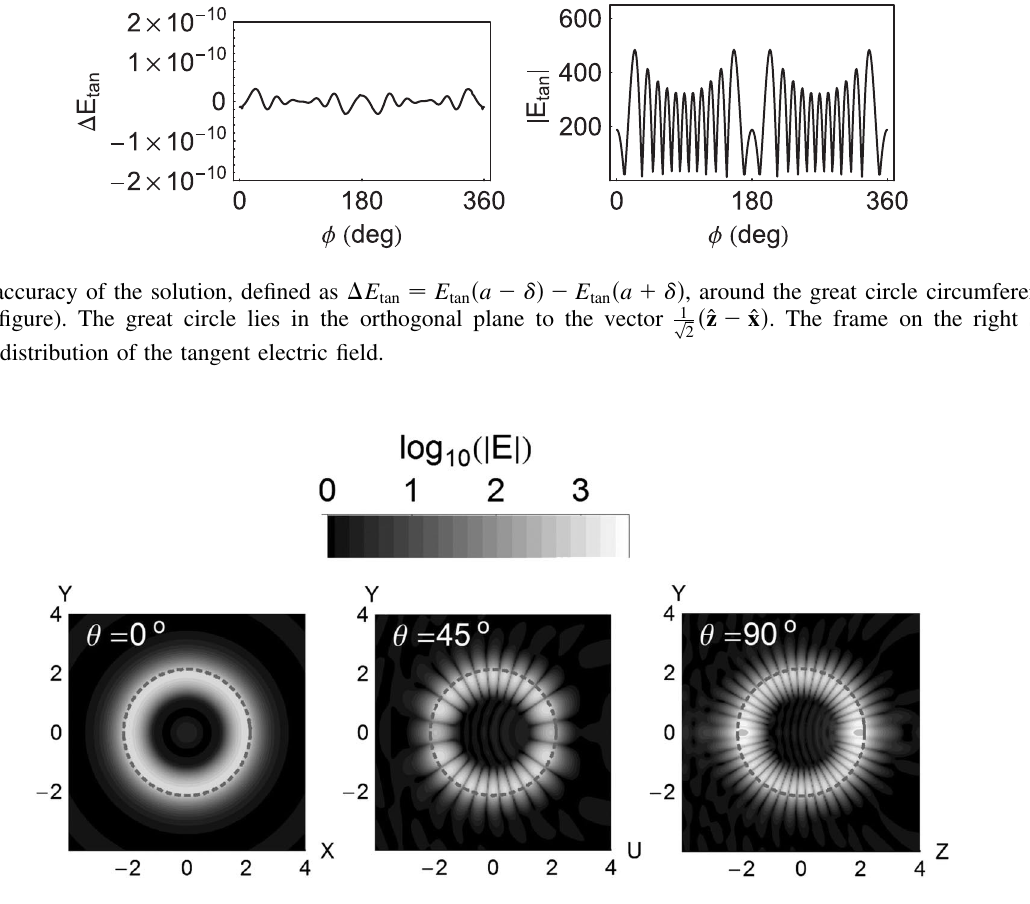
FIG. 4. Electric field distribution of WGM resonance for a perfect dielectric sphere. The sphere is characterized by (cid:1) (cid:2) 4 , radius a (cid:2) 2 : 134 697 , and is excited by a circularly polarized wave propagating along the z axis. The parts of the figure show distributions of the electric field in three planes passing through the center of the sphere, and orthogonal to the vectors: ^ z , 1 (cid:1)(cid:1)